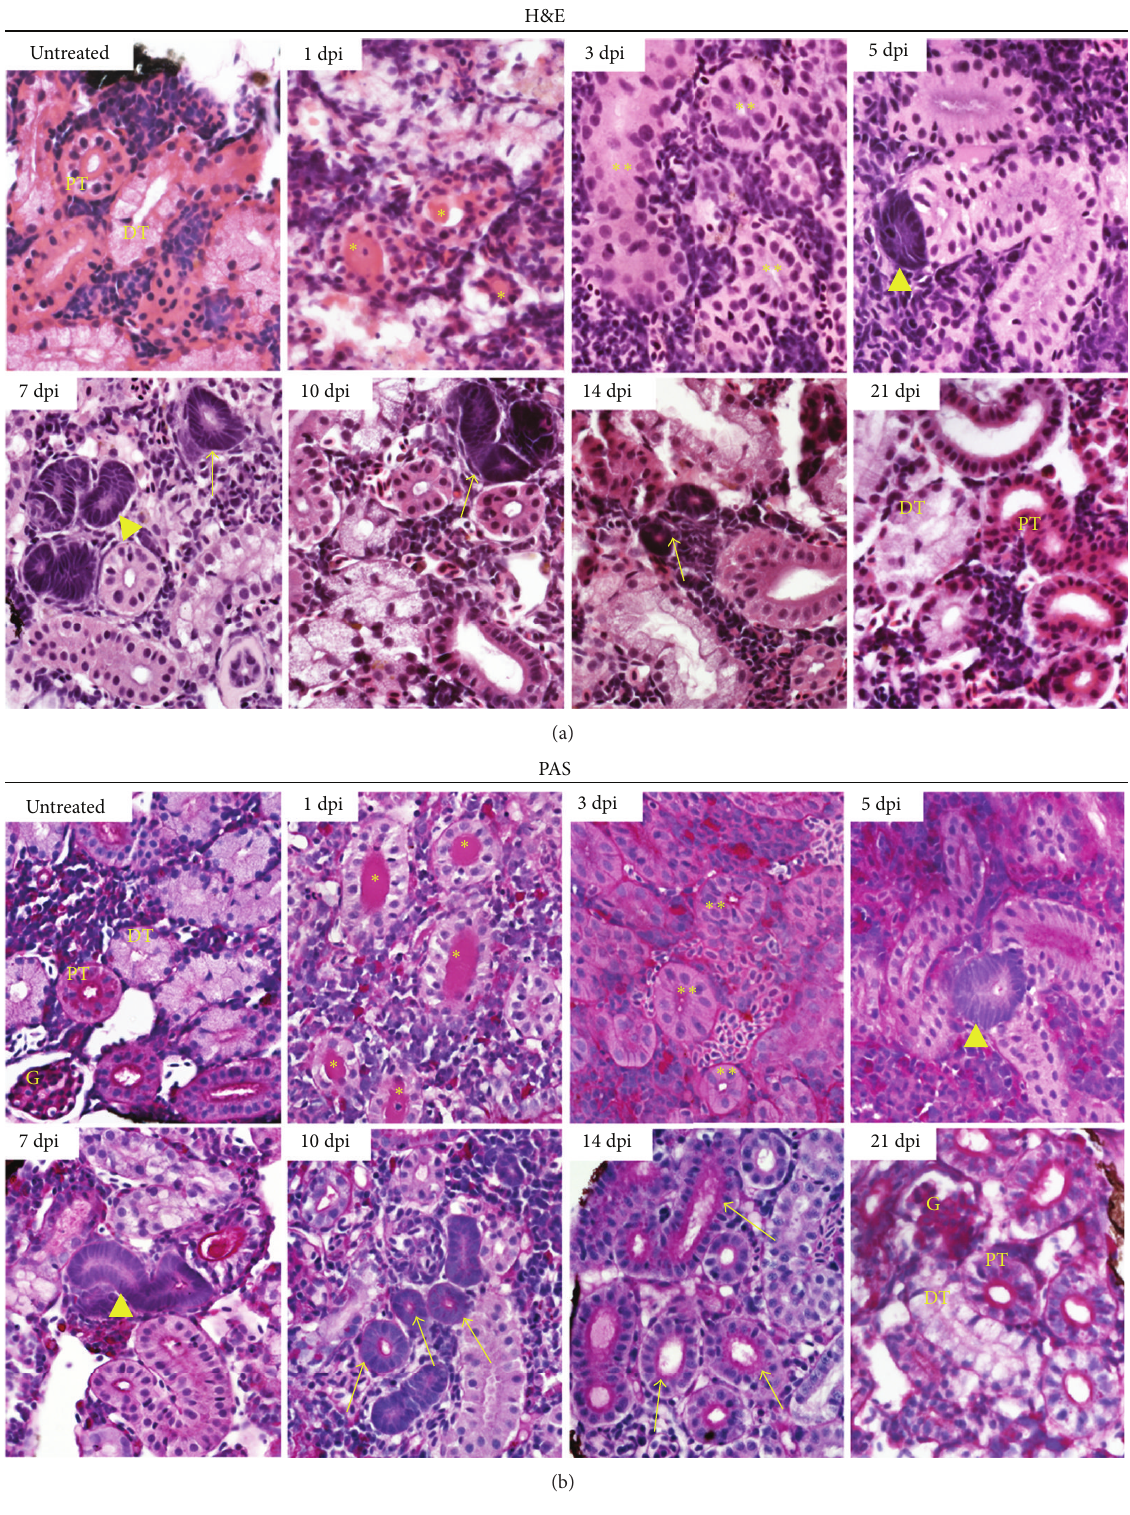
Figure 2: Histological staining reveals the process of regeneration after gentamicin-induced injury in adult zebrafish. (a) H&E and (b) PAS staining demonstrated extensive nephron damage and tubule destruction, followed by regenerative events that were completed by 21dpi. The formation of basophilic cellular aggregates (darkest purple cellular staining) was indicative of new nephron formation. Both time courses were completed over a three-week period. 60x. DT: distal tubule; G: glomerulus; PT: proximal tubule. Yellow labels: asterisk ( ∗ ) indicates luminal debris; double asterisk ( ∗∗ ) indicates restoration of cells to tubules; arrowhead indicates neonephrogenic cluster; arrow indicates neonephron with visible